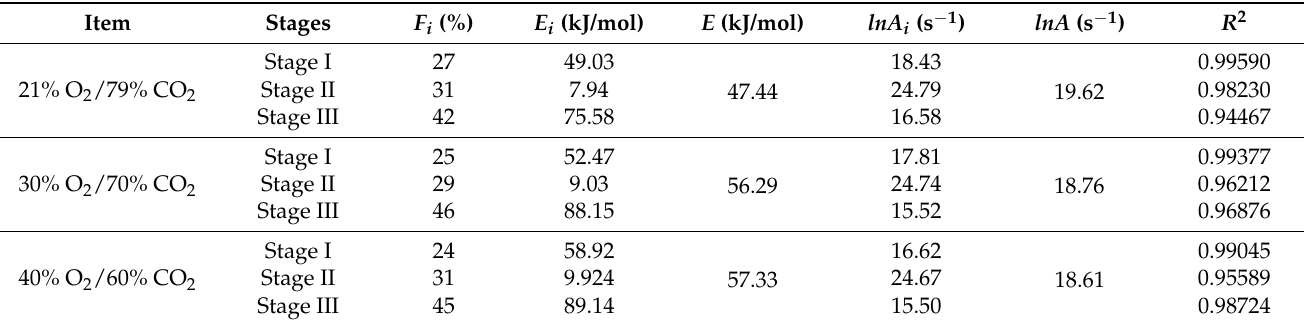
Table 3. Kinetic parameters of 50% SHC + 50% ST under different O 2